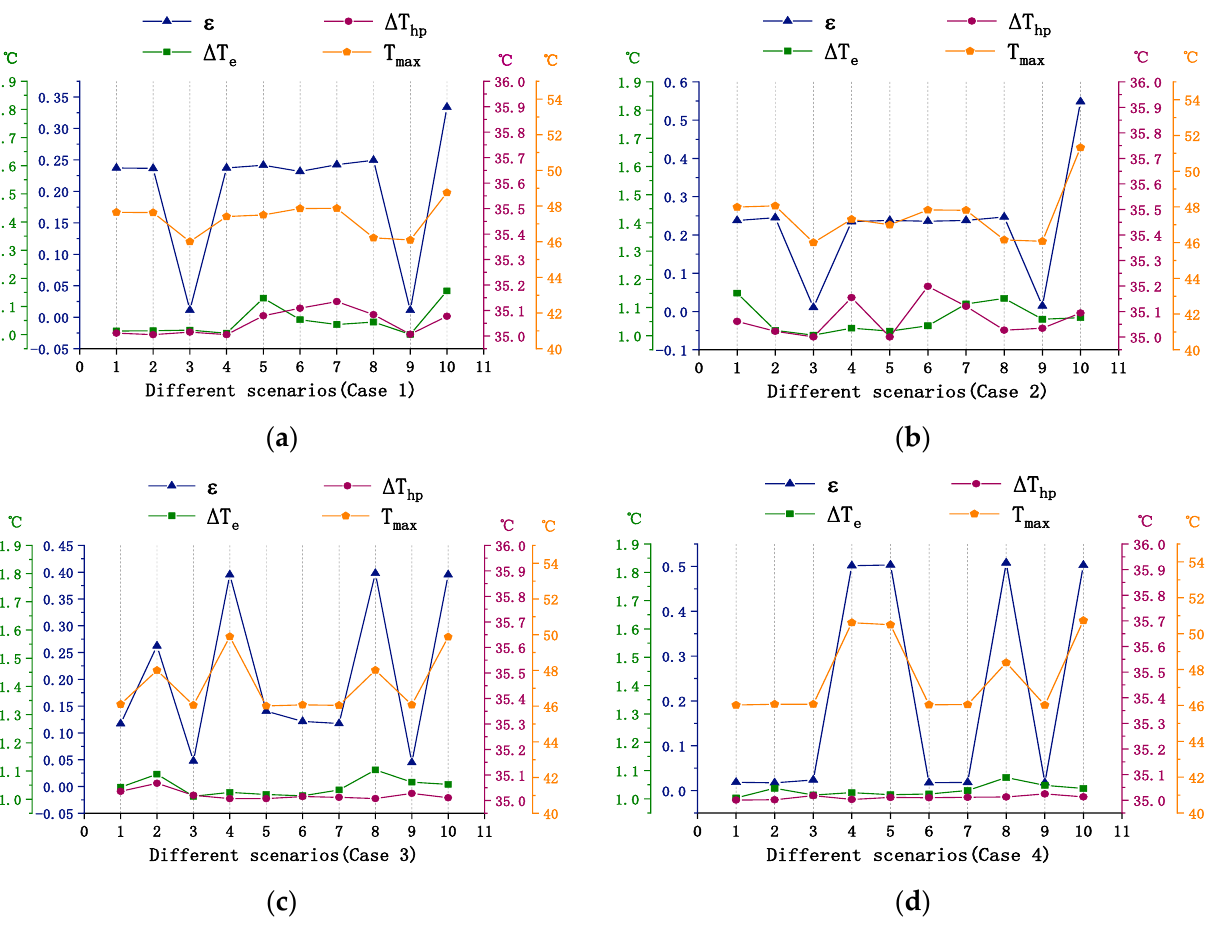
Figure 8. Optimal decision variables for different scenarios under the four strategic conditions: ( a ) Case 1 (Strategy 1); ( b ) Case 2 (Strategy 2); ( c ) Case 3 (Strategy 3); ( d ) Case 4 (Strategy 4). The optimal energy storage ratio ( ε ) essentially reflects the optimal energy storage in the system. If the optimal value of the energy storage ratio approaches 0, it indicates